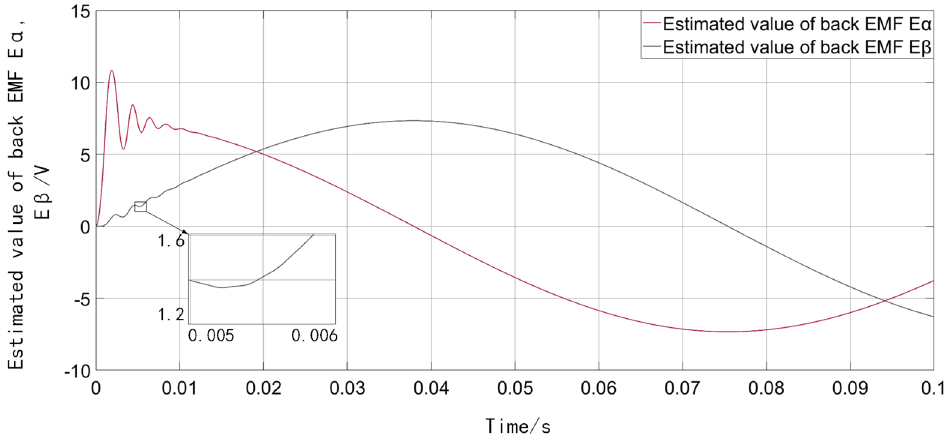
Figure 18. The curve of the estimated value of the two opposite electromotive forces of the new and improved SMO at low speed.